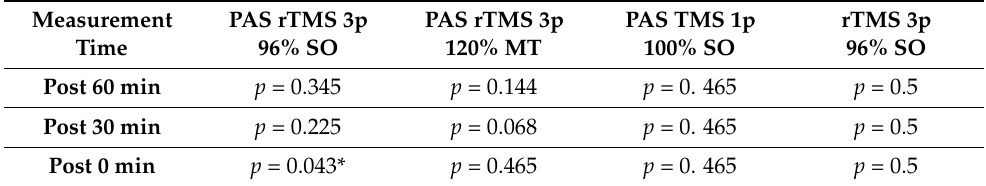
Figure 4. The median values of conditioned stimulus (CS) amplitude divided by unconditioned stimulus (US) amplitude among all subjects ( n = 5) produced by four tested protocols at the pre- stimulation and three post-stimulation measurement points. The values below 100% indicate LICI. Values higher than 100% indicate that the MEP amplitude induced by CS was facilitated. The bars with * sign represent the statistically significant outcomes (see Table 3). Table 3. The p -values for LICI of different protocols at three measurement points from Wilcoxon signed rank test.